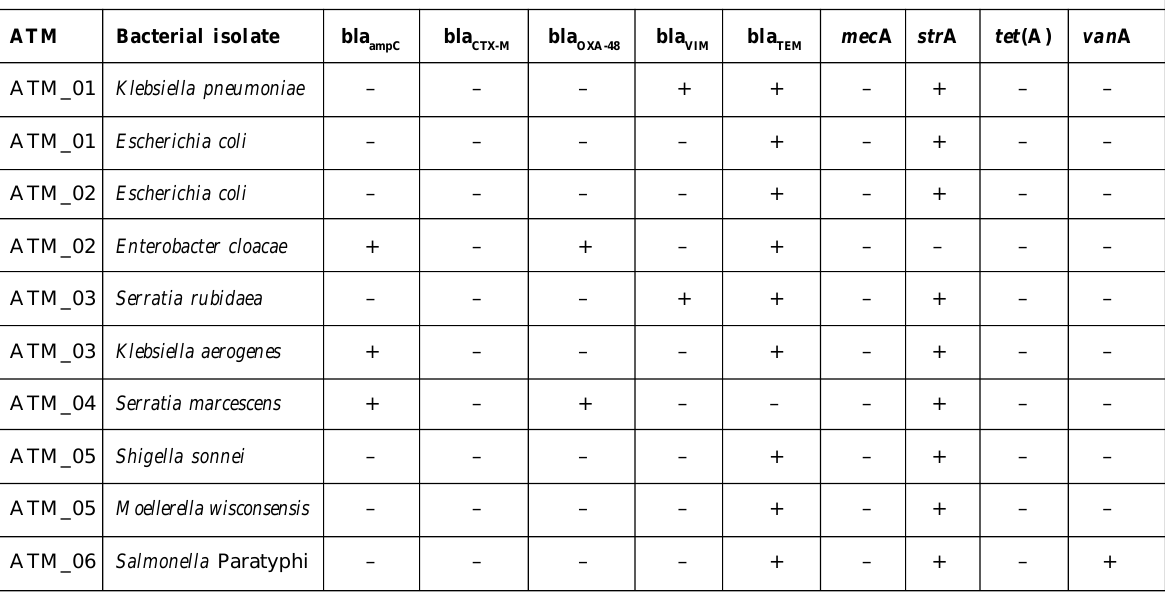
Table 2: Antibiotic resistance gene (ARG) profile of bacterial